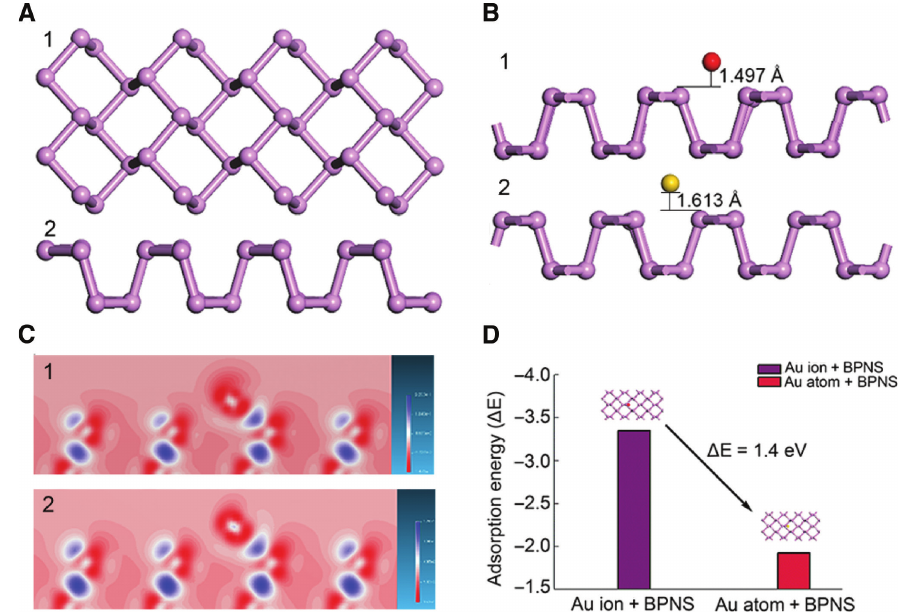
Figure 4: The optimized structures of the bare black phosphorus (BP). (A) (1) top and (2) side views. (B) The optimized structures of the Au atom/ion on BP, where the (1) red and (2) yellow areas represent Au ions and Au atoms, respectively. (C) The electron density difference slices of the BP-Au nanocomposite, where the red and blue areas represent the accumulation and depletion of electrons. (D) Adsorption energy ( Δ E) of Au atoms/ions on the surface of